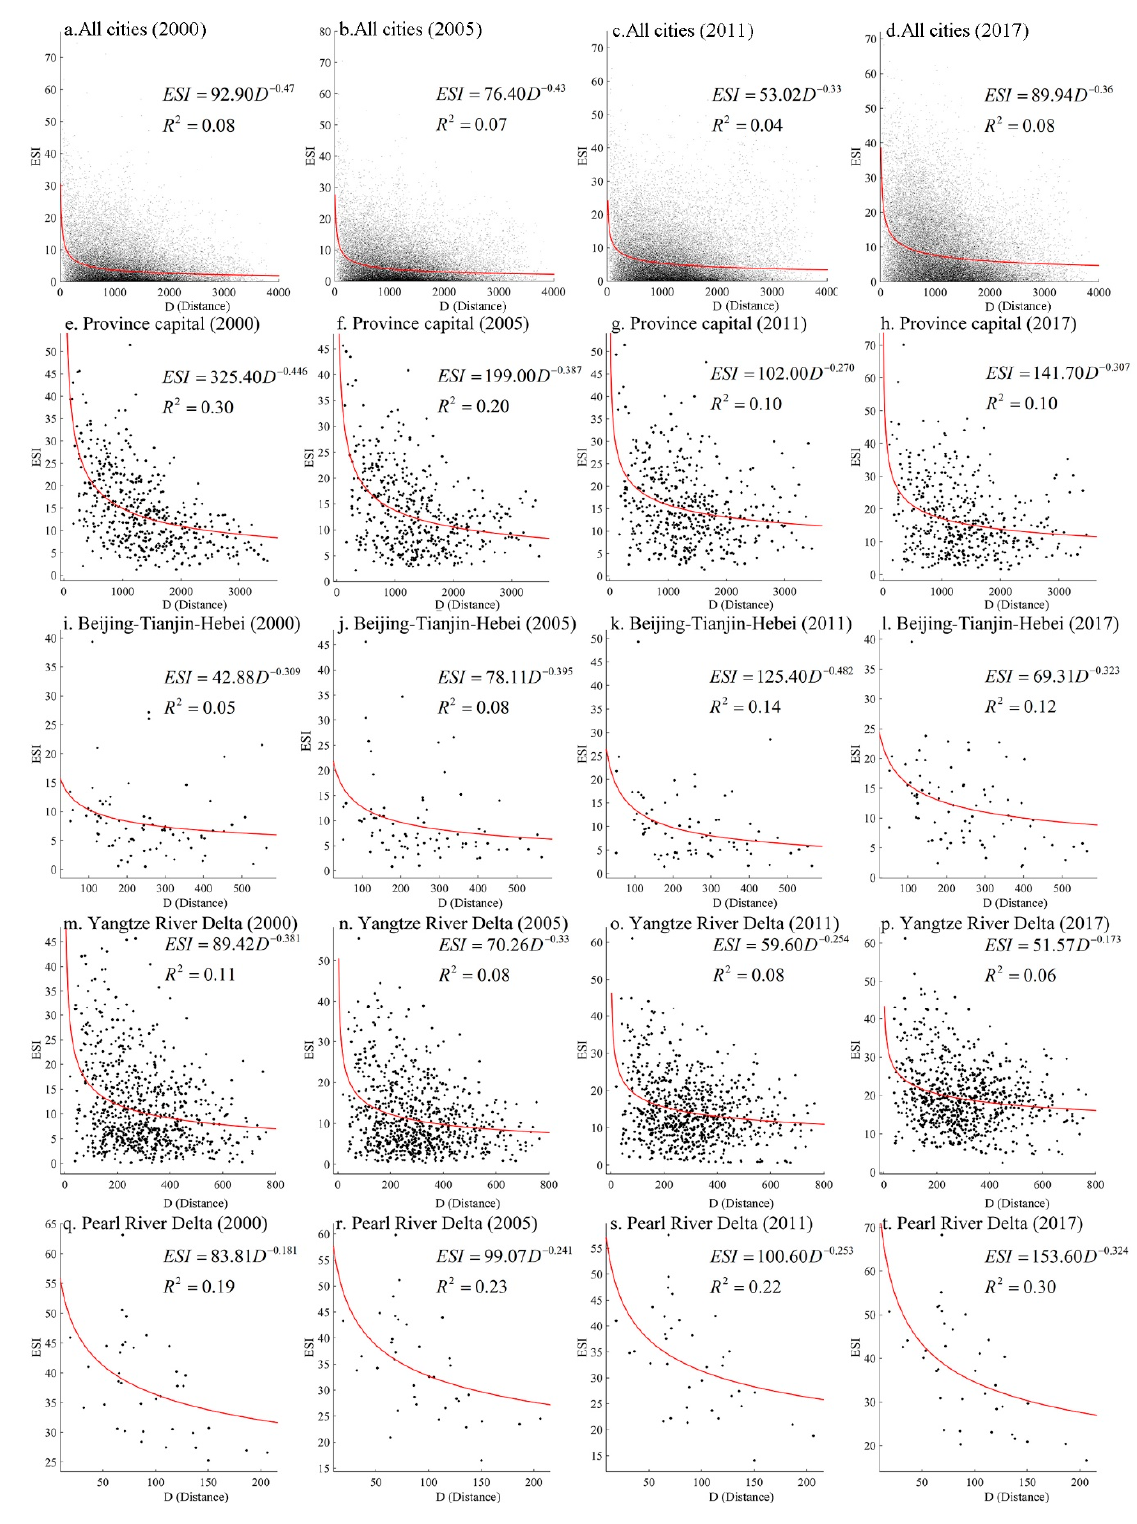
Figure 7. The scatter diagrams and fitting curves of the ESI and distance between cities. Regional